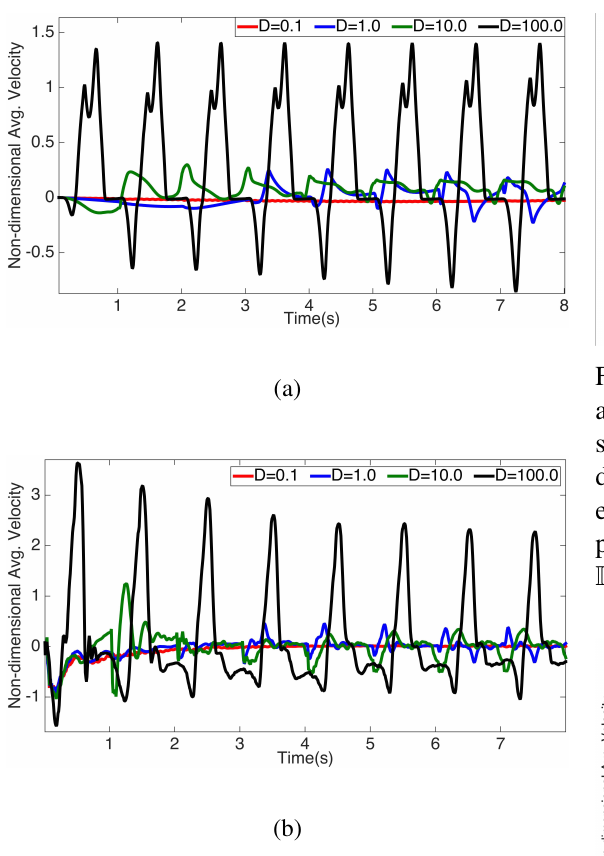
11: A comparison of non-dimensional spatially-averaged velocity computed across a cross-section at the top of the racetrack vs non- dimensional time in the simulation for varying diffusive coefficients, D = { 0 . 1 , 1 . 0 , 10 . 0 , 100 . 0 } . The two plots compare different W o , e.g., (a) W o = 0 . 1 and (b) W o = 10 .